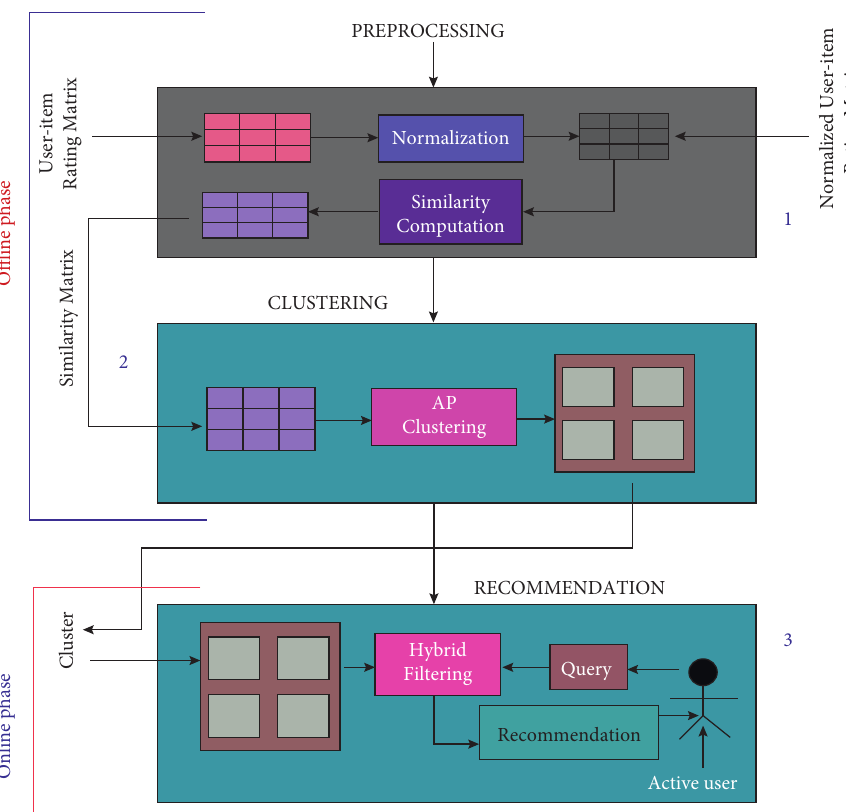
Figure 2: Affinity Propagation-Based Hybrid Personalized Recommender